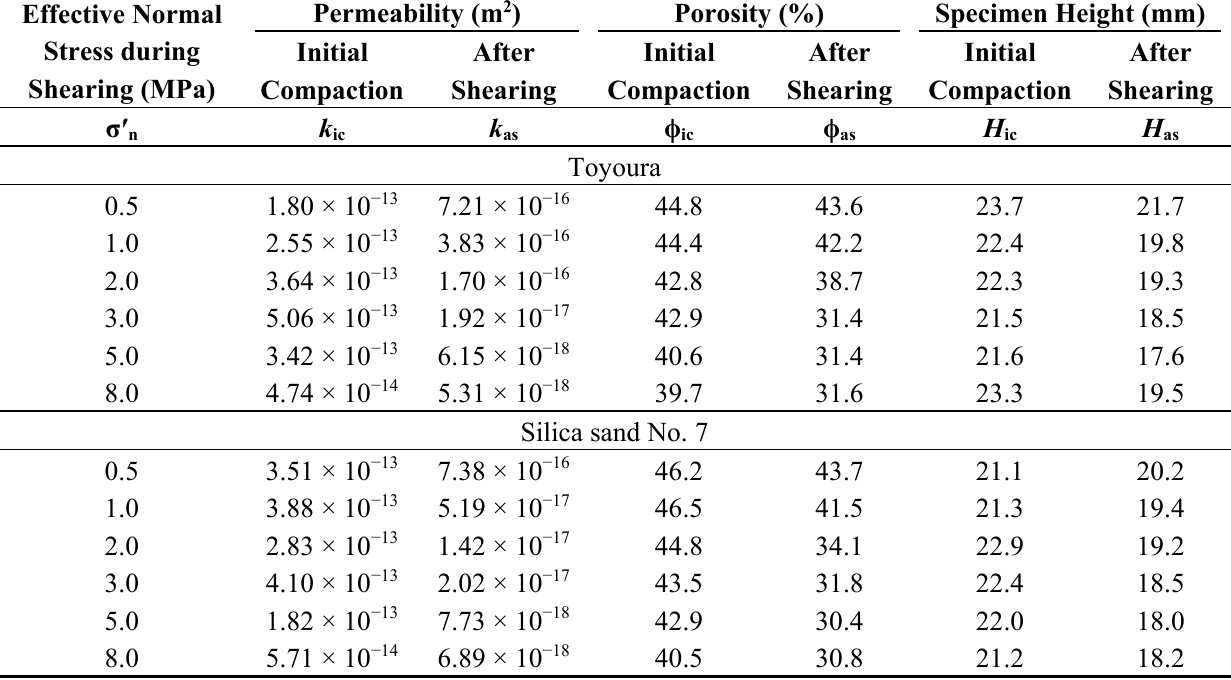
Table 1. Permeability and porosity after initial compaction and after shearing in sand